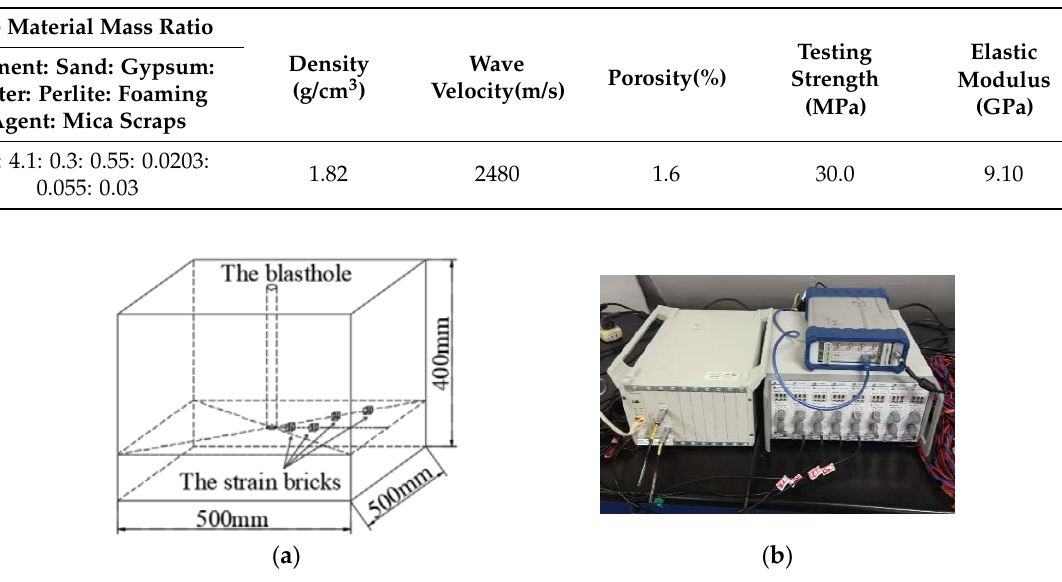
Table 4. The material mass ratio and physico-mechanical parameters of the sample.